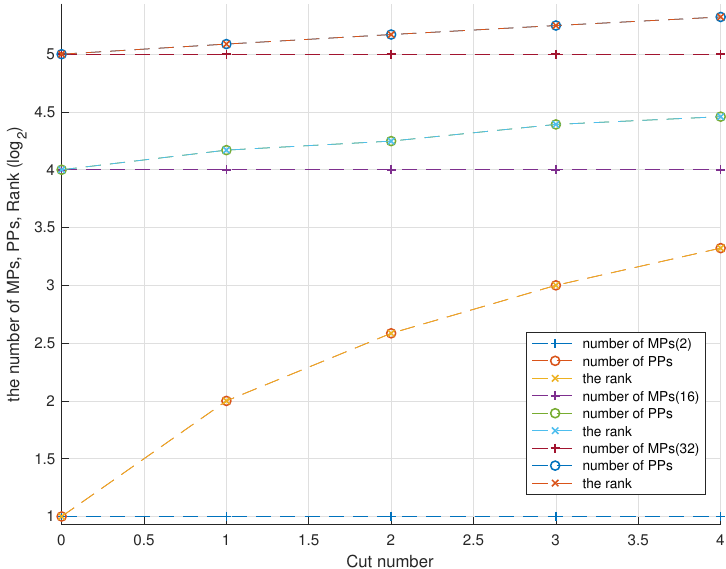
Figure 5. When the number of initial mathematical patches is different, as the number of discontinuities increases, the rank of the matrix and the number of PPs also change. The initial number of MPs are